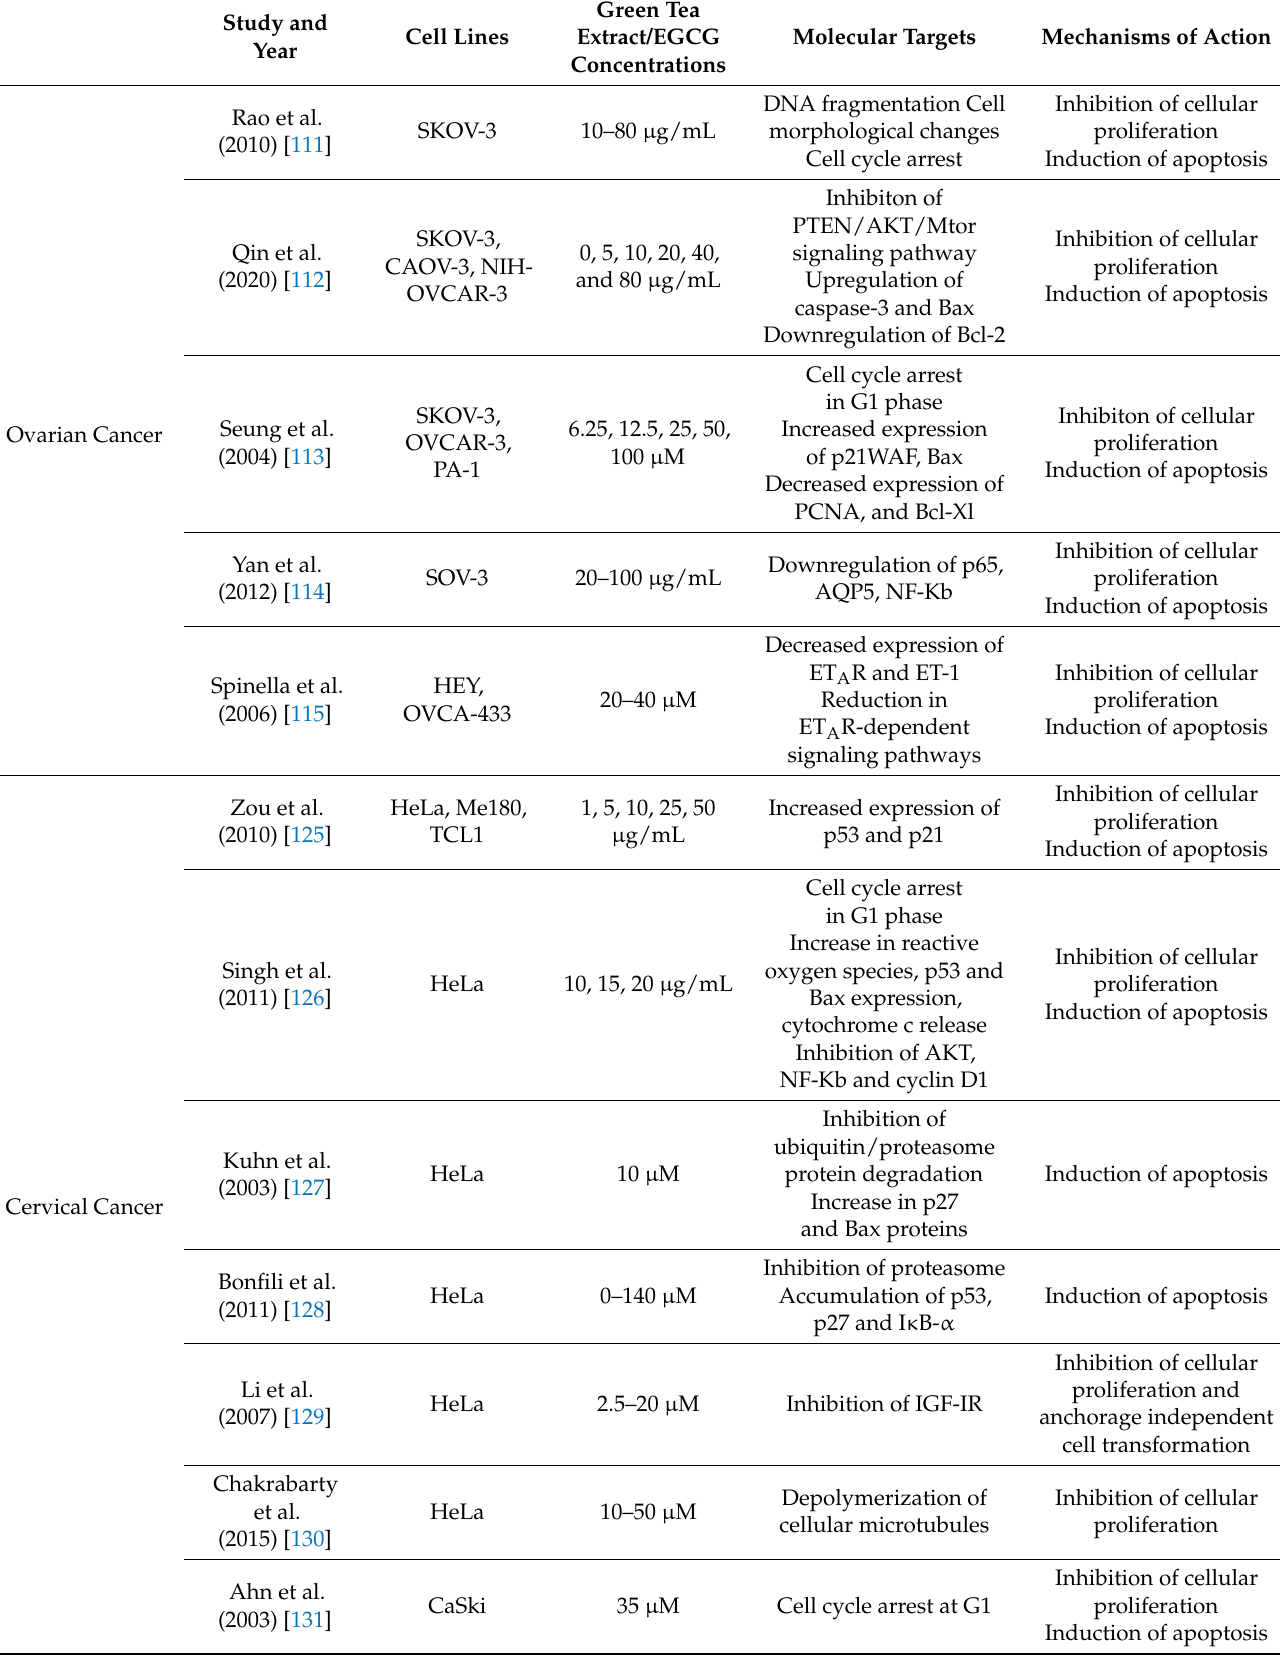
Table 1. In vitro studies examining the effect of green tea on reproductive cancers. Study